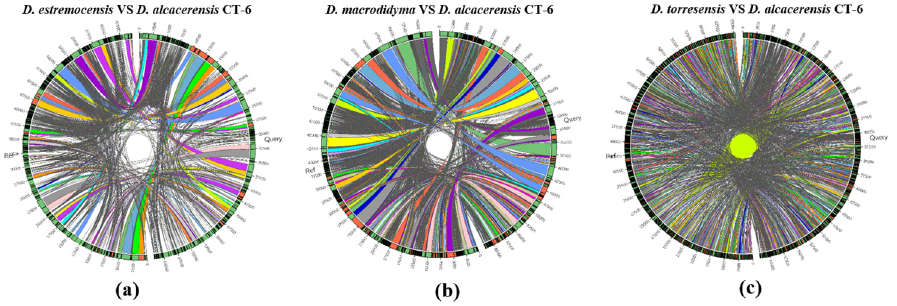
Figure 6. Genome collinearity analysis between D. alcacerensis CT-6 and D. estremocensis ( a ), D. alcacerensis CT-6 and D. macrodidyma ( b ), D. alcacerensis CT-6 and D. torresensis ( c ).